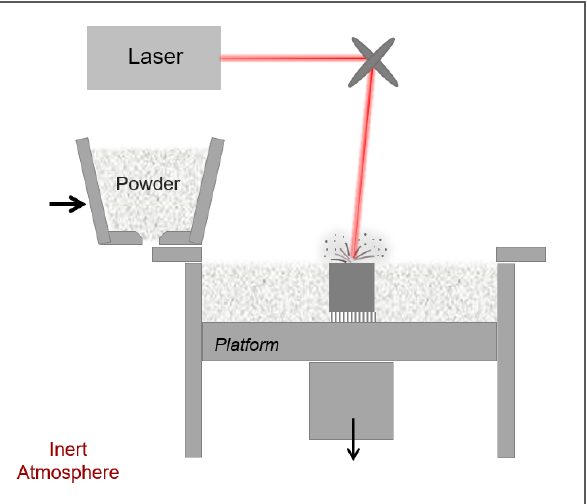
Figure 2. Schematic representation of the Selective Laser Melting (SLM) process.